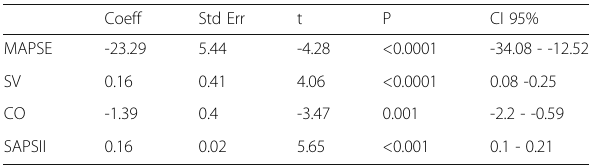
Table 99 (abstract A310). Outcome predictor